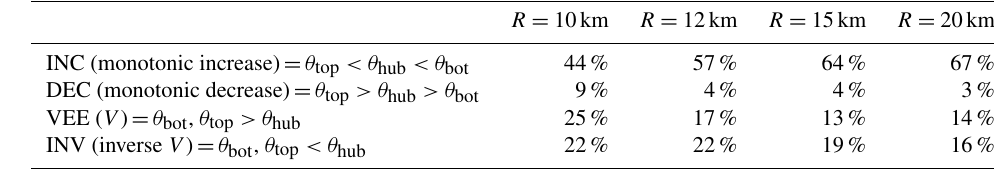
Table 1. Percentage occurrence of the four different veer profiles at each reference radius.